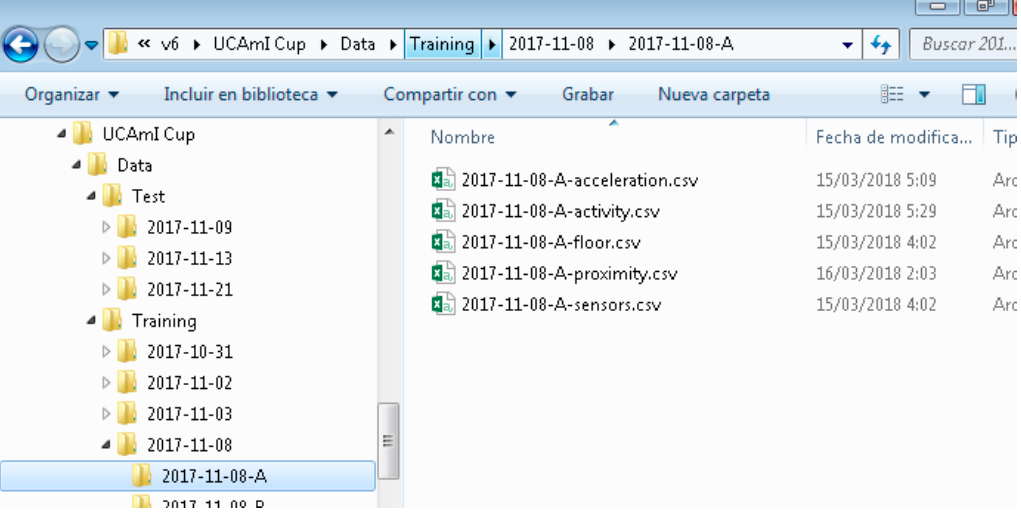
Figure 5. Examples of files included in the data folder called “2017-11-08-A” in the training set. As an example, the files included in the day-folder named “2017-11-09-A” are presented in Figure 6. This day is contained in the test set and therefore does not include any labelling of the data.